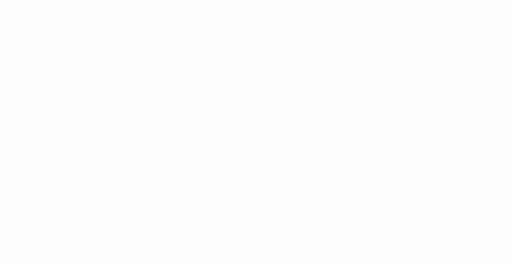
Fig. 1: Viscosity as a function of temperature for a resin, with an Arrhenius fit through the